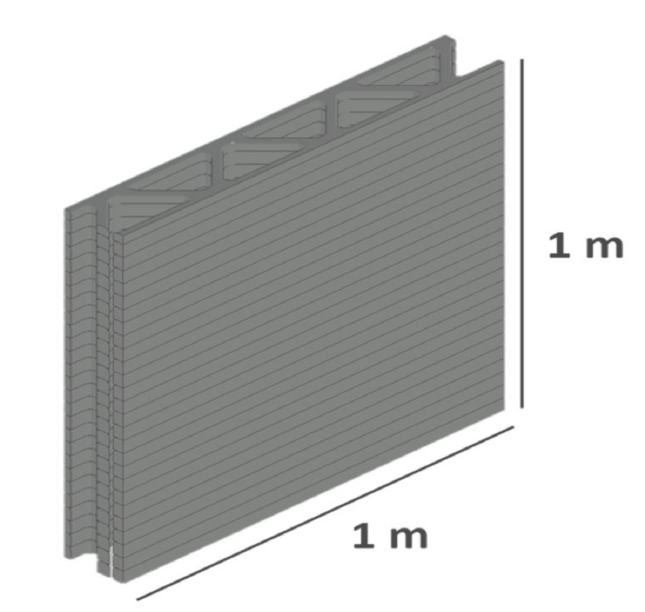
Figure 6. Graphic of 3DCP wall section for (S-3) and (S-4).